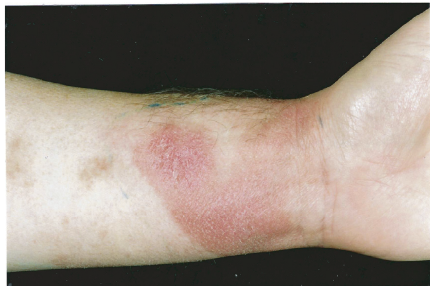
Figure 2: Plaque of mycosis fungoides on the anterior left